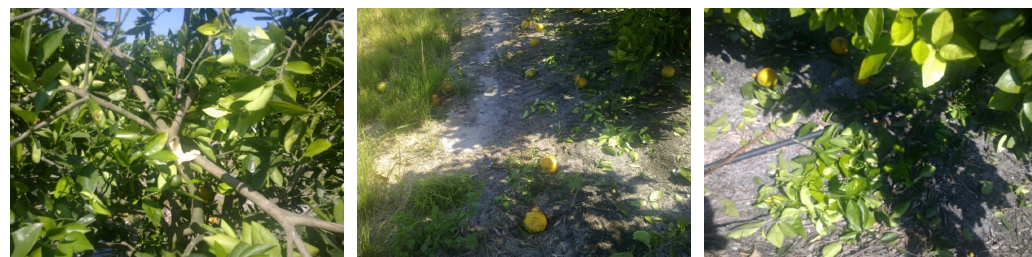
Figure 4. Photographs are showing some of the mechanical harvesting damages to fruit, leaves, and stems of citrus trees during harvesting seasons.